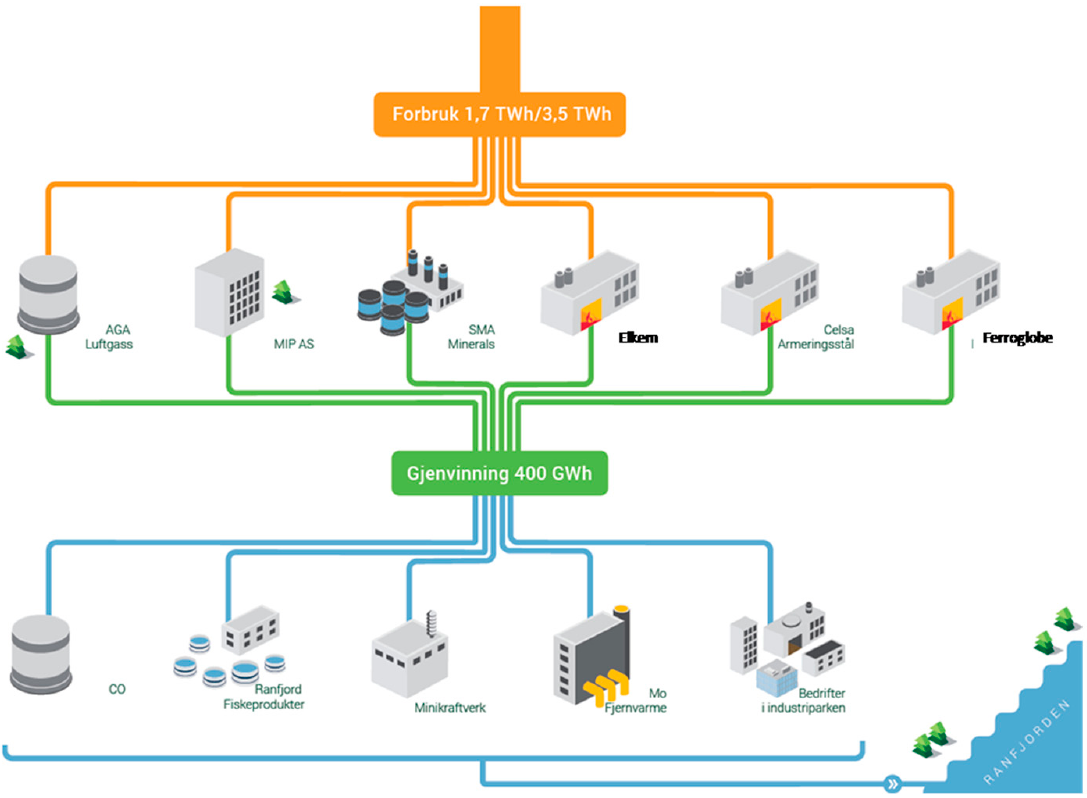
Figure 1. Energy recovery at Mo Industrial Park (adapted from MIP Magasinet 2016).